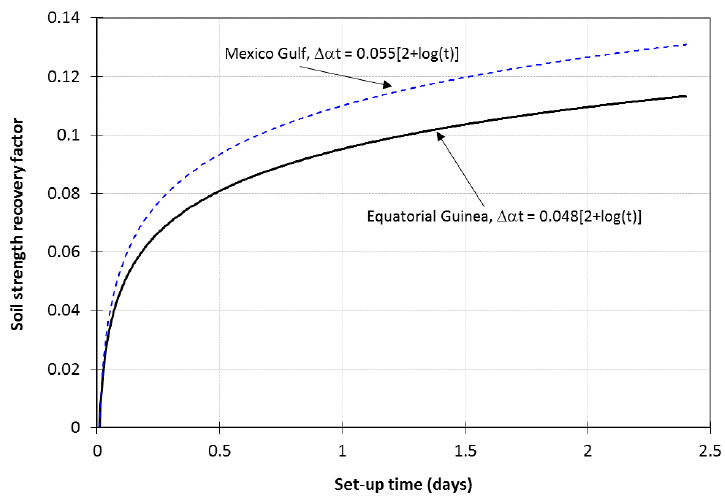
Figure 6. Comparison of soil strength recovery model in the Gulf of Mexico and Equatorial Guinea.